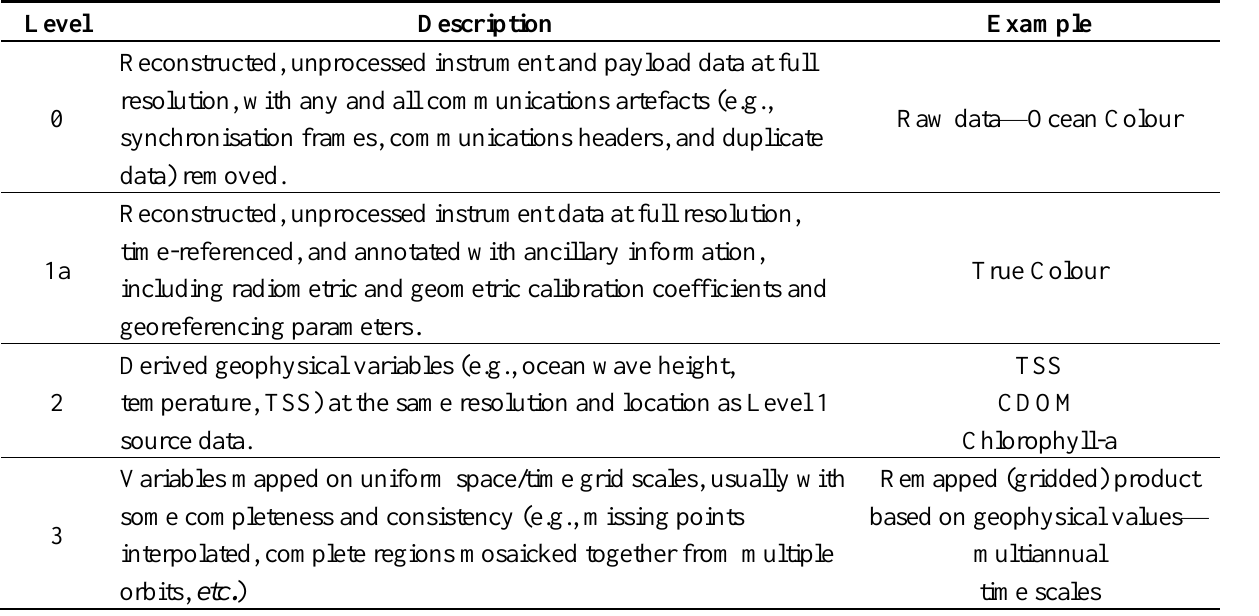
Table 1 . Terminology associated with the different processing steps to create levels of remotely sensed data. Terminology derived from